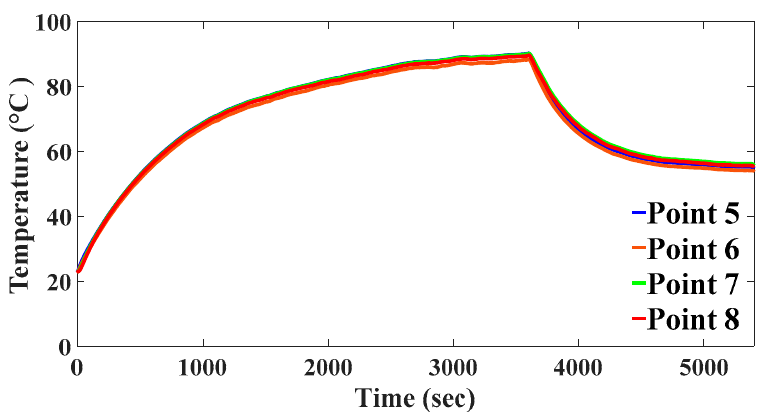
Figure 23. Temperature responses in Type II heat-source point.